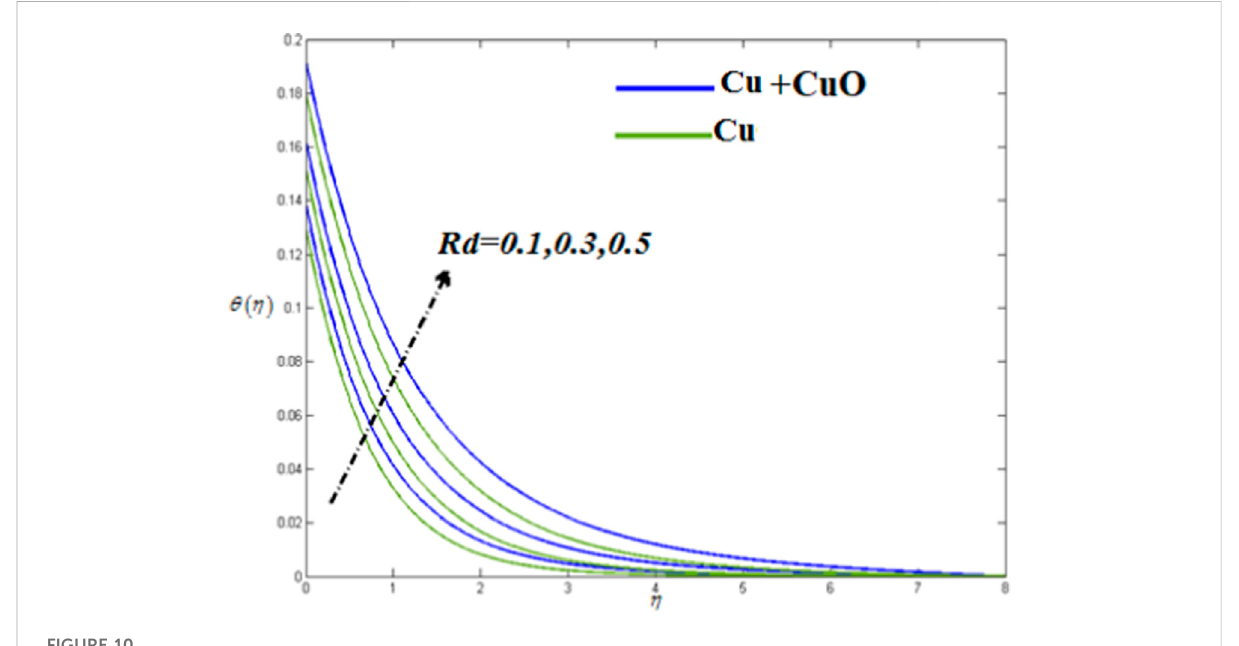
FIGURE 10 Rd versus θ ( η ) . When, k (cid:2) 0 . 2 , Λ (cid:2) 0 . 4 , B i (cid:2) 0 . 2 , ϕ 1 , ϕ 2 (cid:2) 0 . 02 , Gr (cid:2) 0 . 1 , Pr (cid:2) 6 . 2.